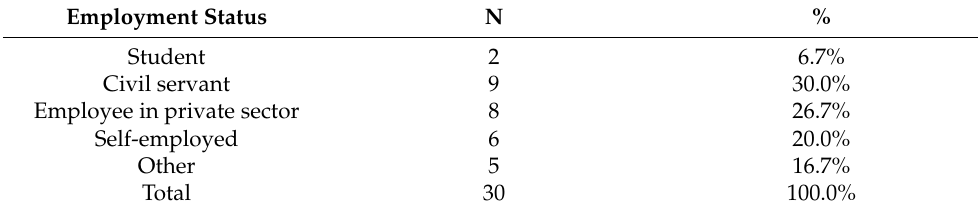
Table 4. Respondents’ employment status.